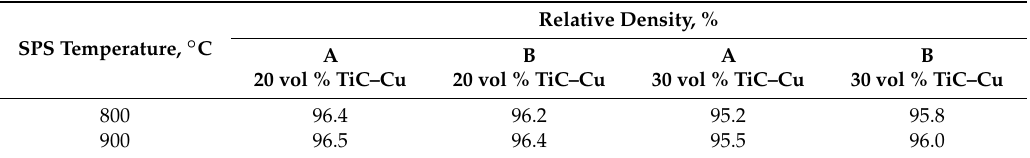
Table 6. Relative densities of the spark plasma sintered (SPS) TiC–Cu